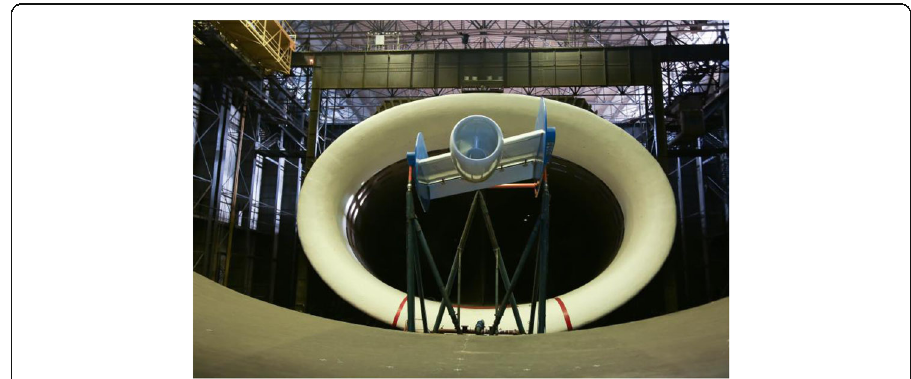
Fig. 3 Model of nacelle+wing segment with high-lift devices inside T-101 wind tunnel (AFLONEXT project: